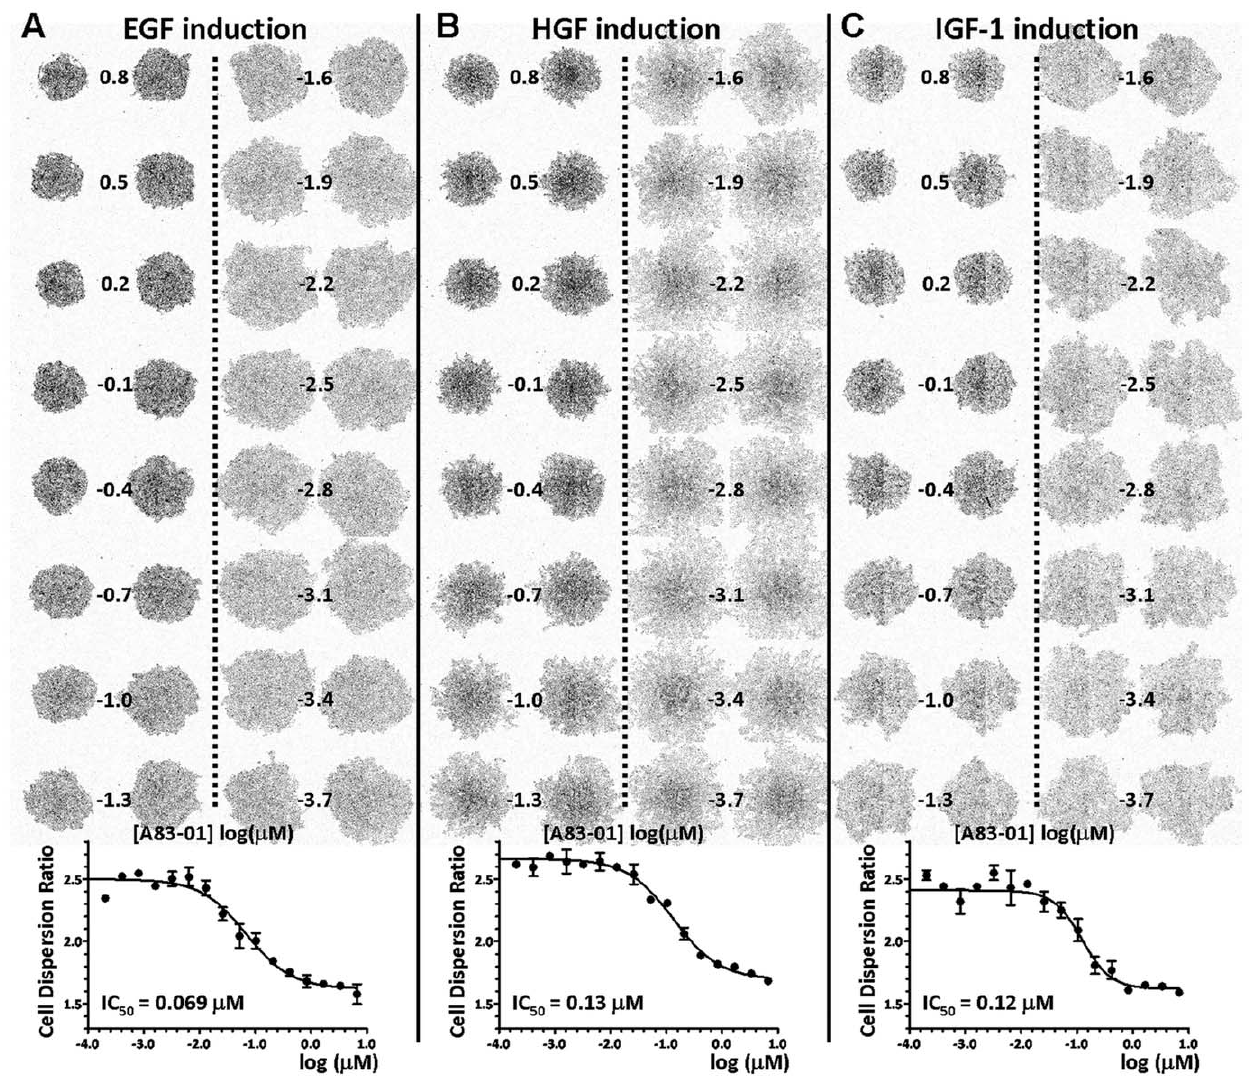
Figure 5. EMT inhibitory property of an ALK5 inhibitor, A83-01. T2 plate image and CDR dose response profile of A83-01, against EGF- (A) HGF- (B) and IGF-1- (C) induced EMT.